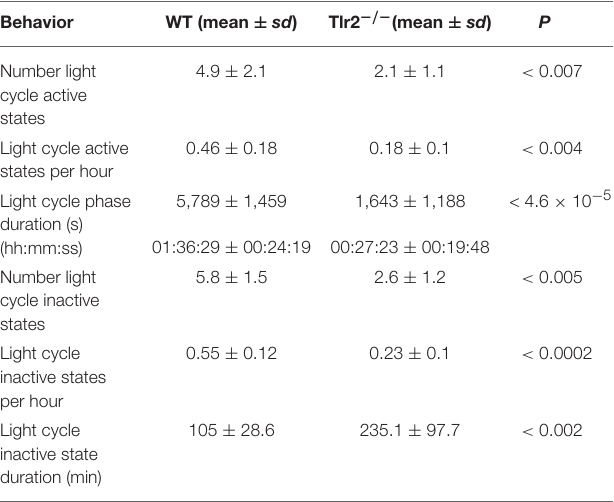
TABLE 2 | Comparison of light cycle (LC) overall active and inactive state properties between 4 and 4.5 months old WT and Tlr2 − / −